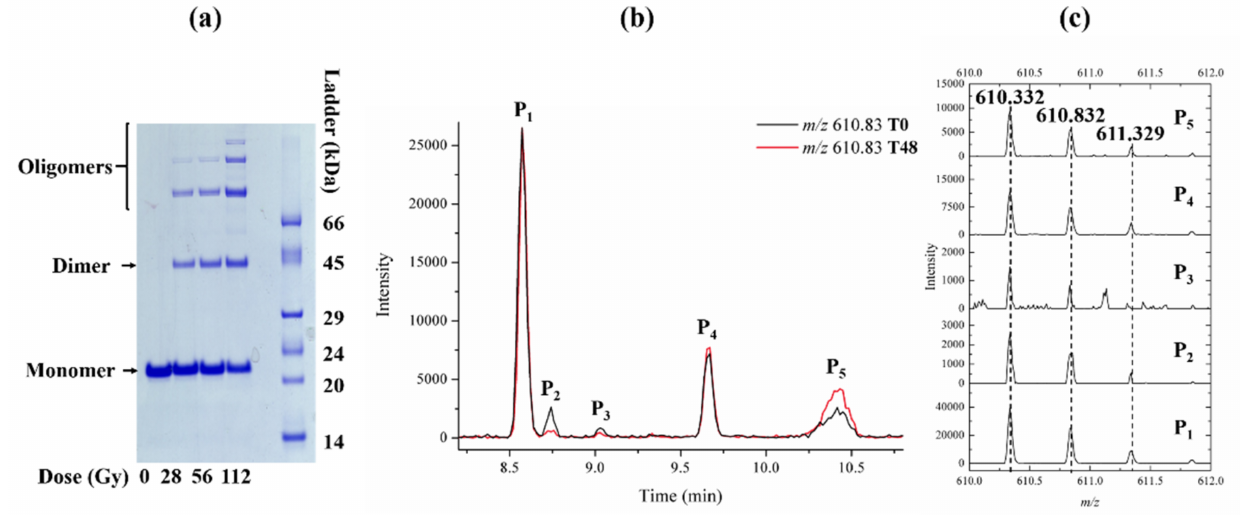
Figure 3. HsCen2 oligomerization at 40 Gy in N 3 • production conditions. ( a ) SDS-PAGE to evidence covalent oligomers; ( b ) mass analysis of tryptic fragment before and after a 48 h incubation at 37 ◦ C, extracted ion chromatograms ( m / z 610.83 ± 0.05) corresponding to KTSLY- C YLSTK N dimer; ( c ) full scan MS of dimer for [M + 2H] 2+